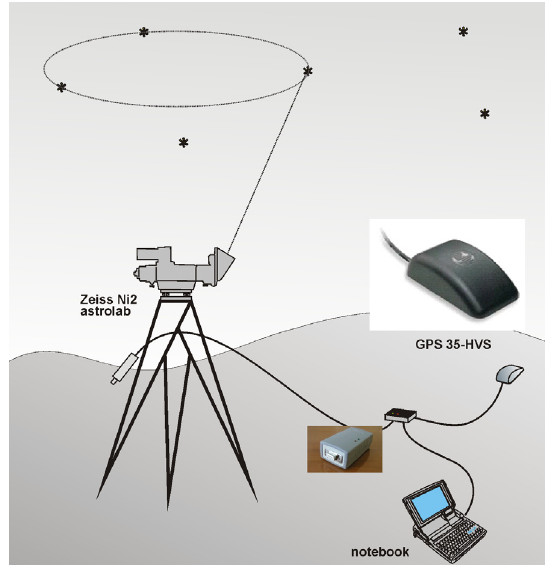
Figure 2 (above). The problem of three heights. Figure 3 (right). Automated system for the simultaneous ( U , K )